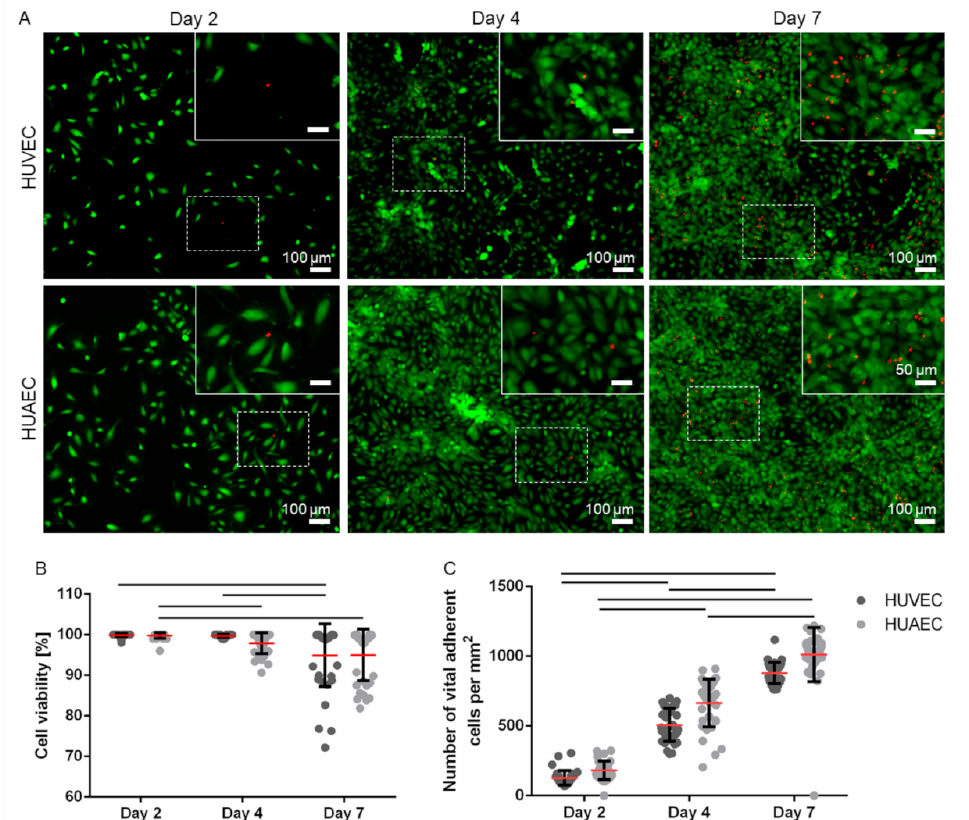
Figure 2. Endothelial cell viability and density. Human umbilical cord-derived endothelial cells from veins (HUVEC) or arteries (HUAEC) were seeded at a density of 15,000 cells/well at day 0, and cultivated for 2, 4, and 7 days. Cell viability staining detected living (green) and dead (red) cells ( A ). Quantification of vital cells showed that only a few cells died over time ( B ). The cell density, expressed as the number of vital adherent cells per mm 2 , increased over time ( C ). Fluorescent images were taken at 10-fold primary magnification. Scale bar represents 100 µ m, and 50 µ m in the magnified image sections in the upper right corner of each image. Squares with dashed lines indicate the image region that was magnified. Straight black lines indicate p ≤ 0.0099.